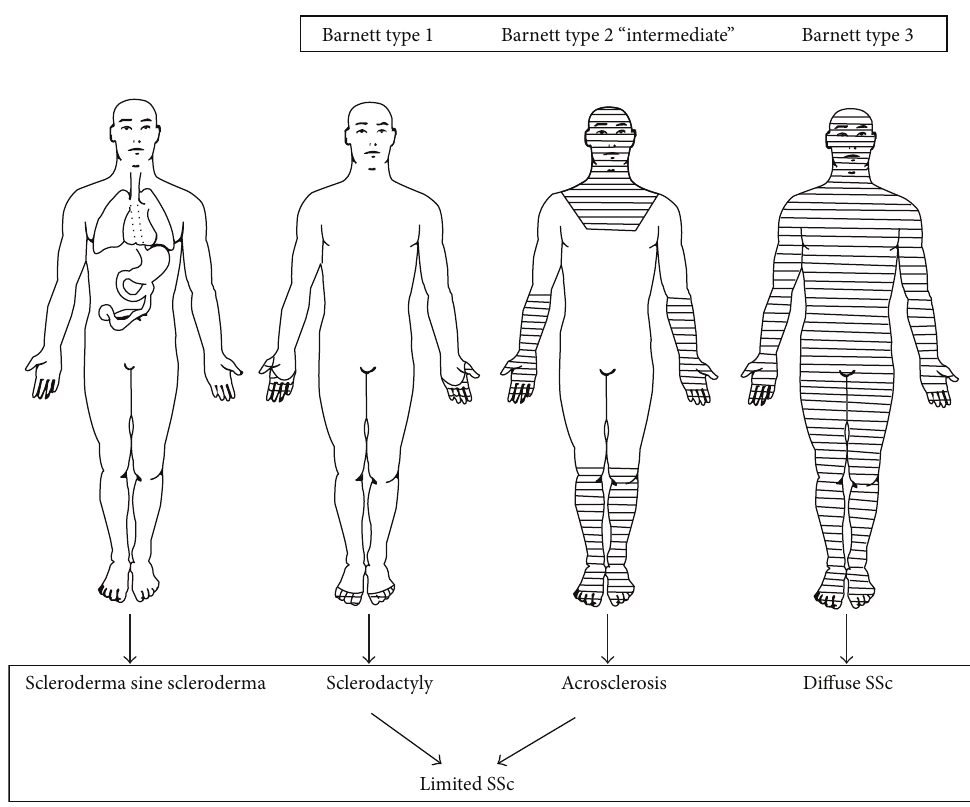
Figure 1: Clinical Subsets according to extension of skin